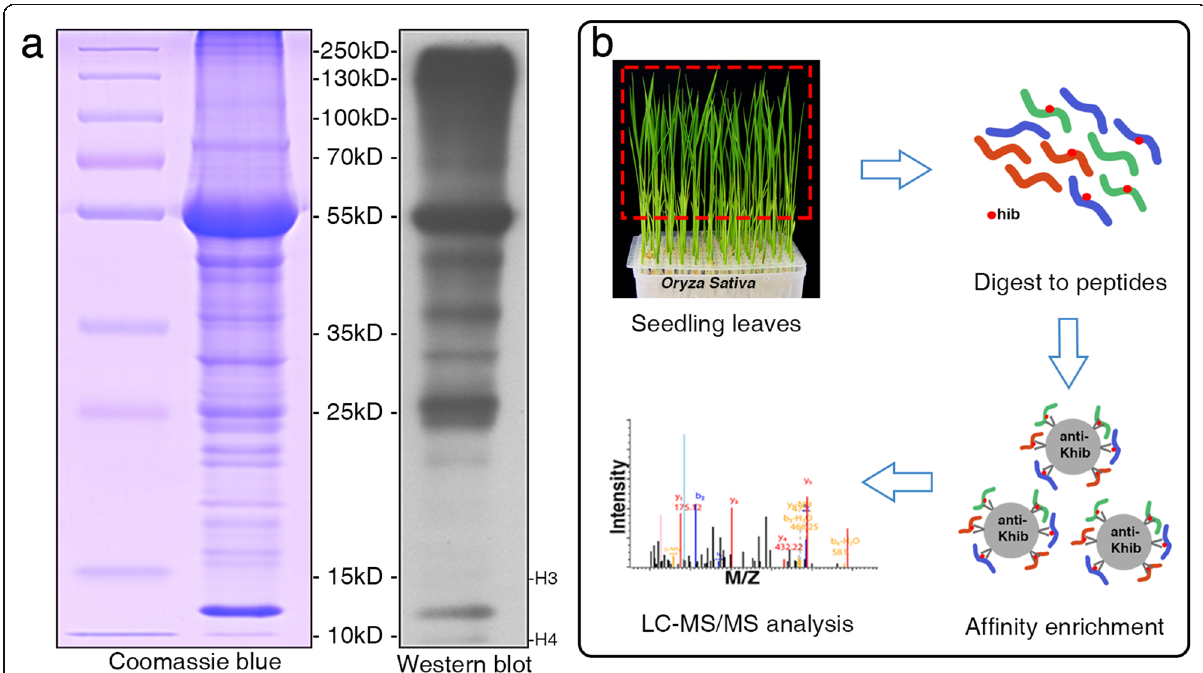
Fig. 1 Workflow for large-scale identification of Khib sites in rice. a Western blotting analysis of total proteins in rice seedling leaves. The gels for SDS-PAGE were stained with Coomassie Blue. b Workflow for identification of Khib modification in rice. Total proteins extracted from seedling leaves were digested to peptides by trypsin. Peptides bearing Khib sites were affinity enriched with a specific Khib antibody and subsequently analyzed by